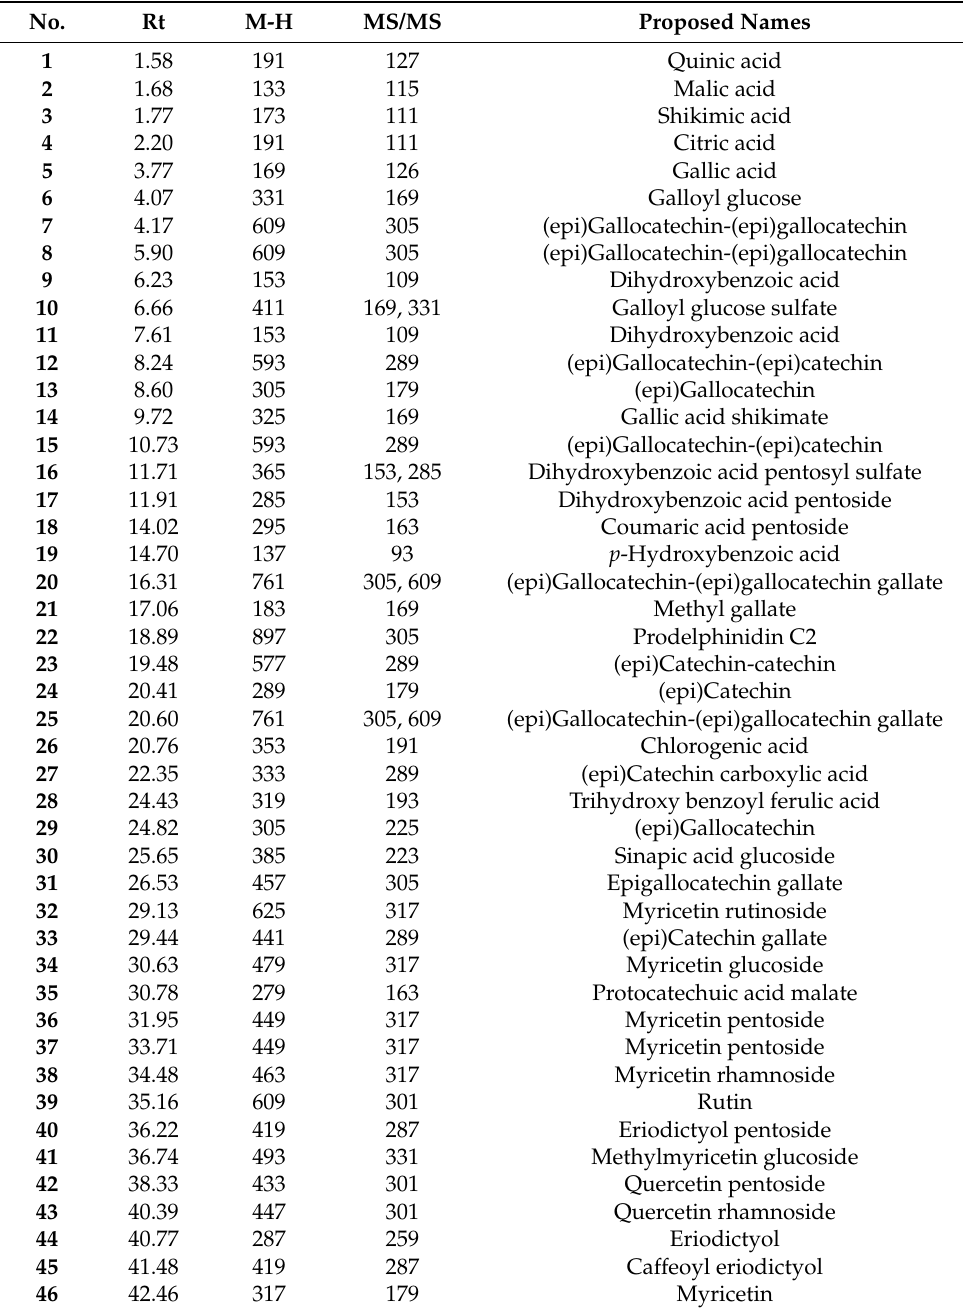
Table 1. E. divinorum leaf extract composition by